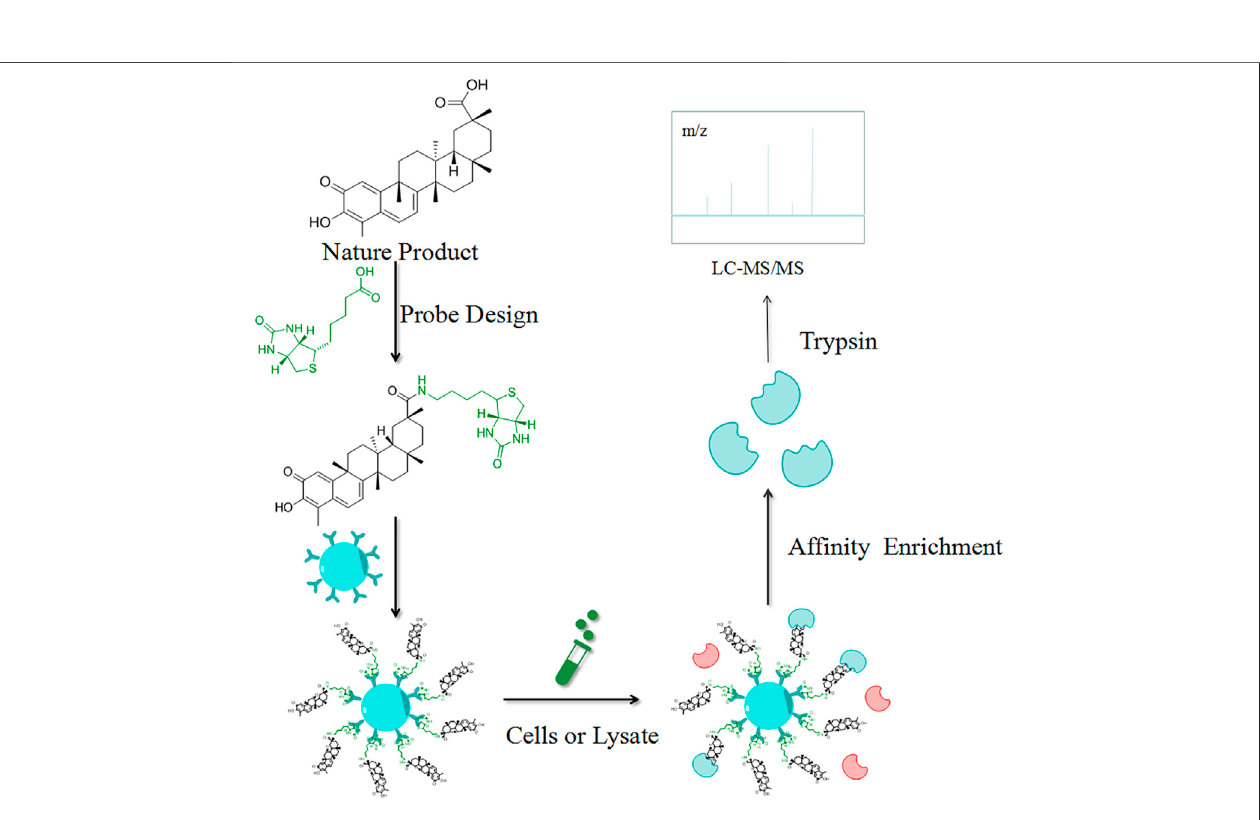
( Figure 1 ): 1) the active group is a structure with special biological activity in the NPs that can directly bind to the